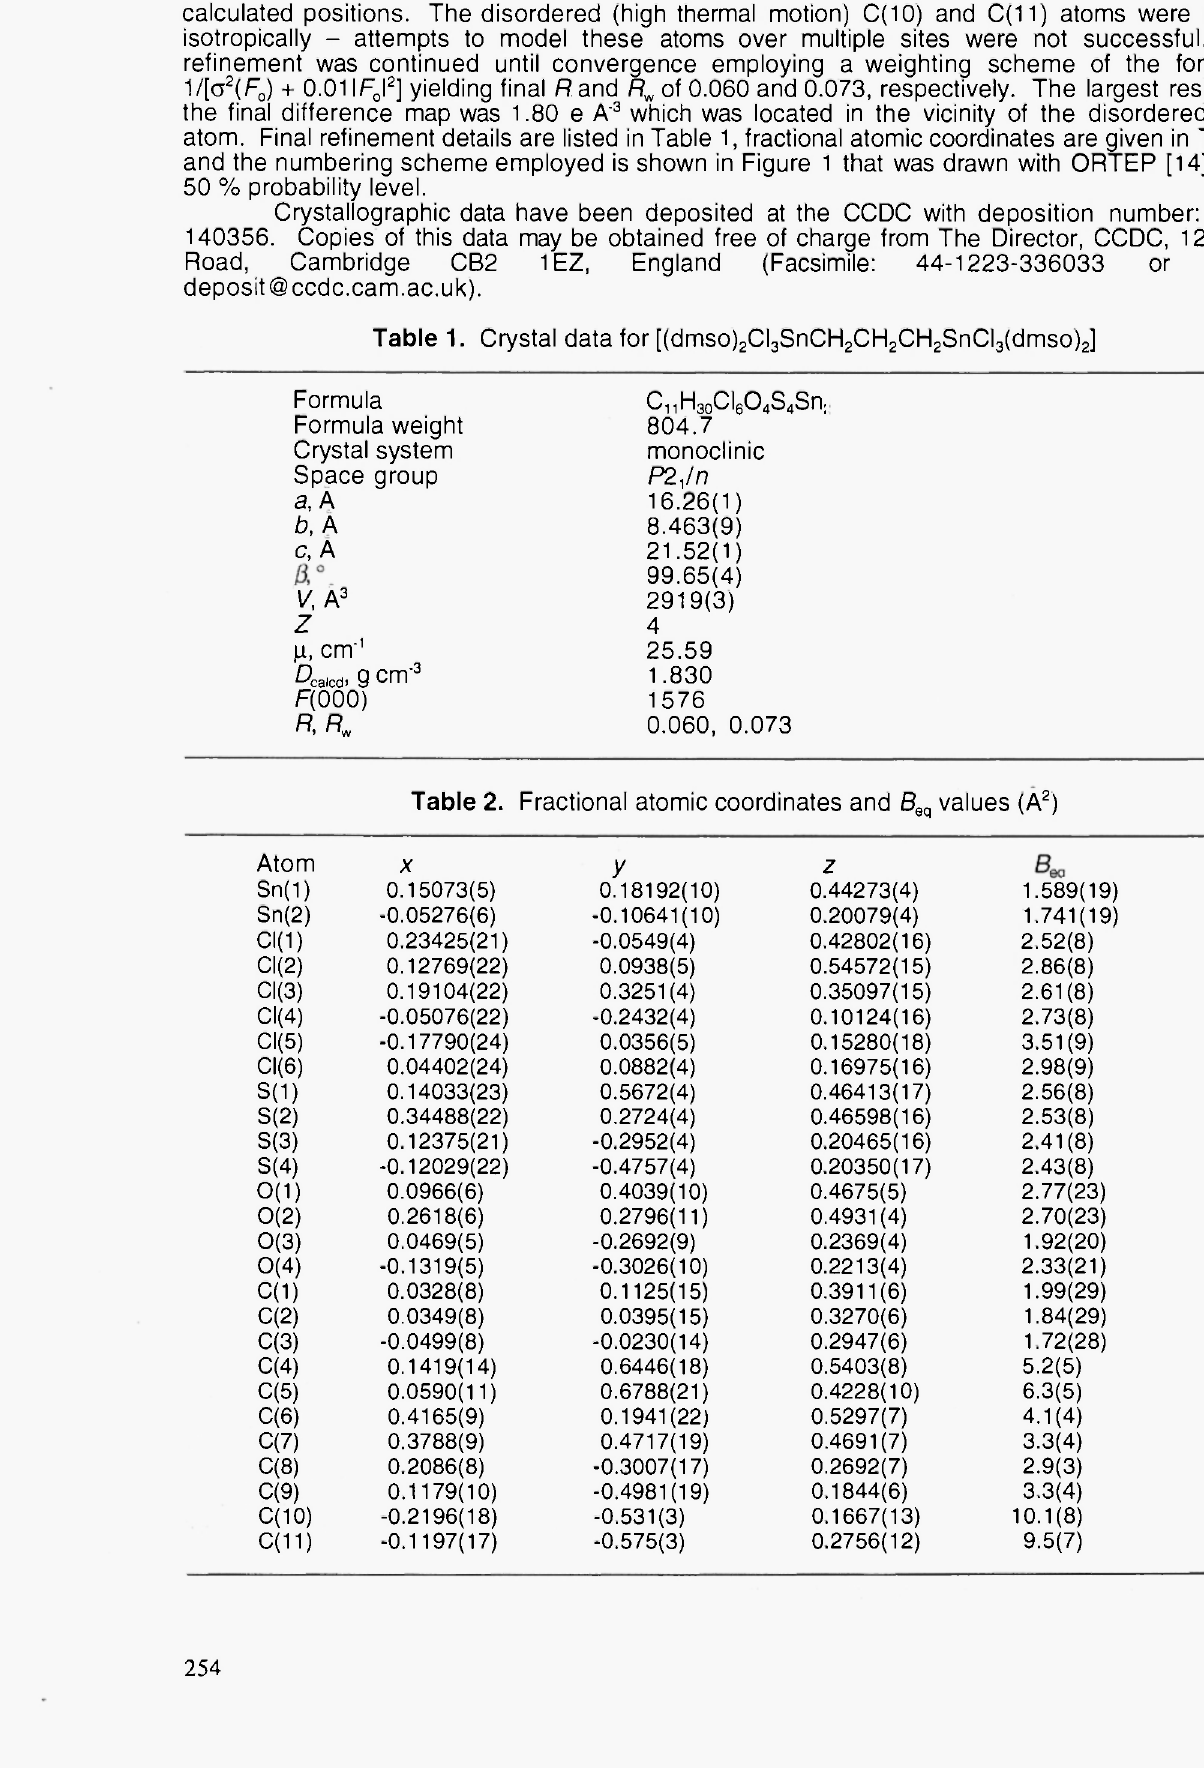
Table 1. Crystal data for [(dmso) 2 CI 3 SnCH 2 CH 2 CH 2 SnCI 3 (dmso) 2 ]